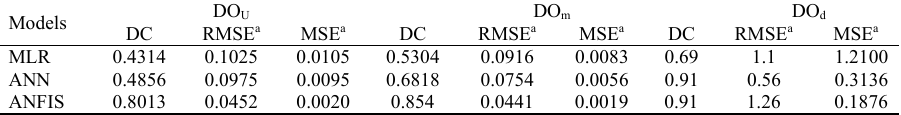
Table 5: Performance evaluation result for ANFIS model